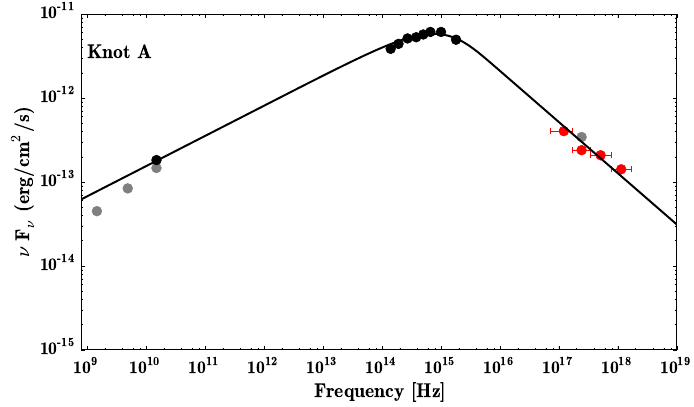
Figure 12. Representative multi-wavelength SED for the outer knot A in the kpc-scale jet of M87 including X-ray emission (red) based on 1.5 Msec of Chandra data. The emission is thought to be synchrotron in origin, indicating the presence of electrons up to multi-TeV energies within the jet. Inverse Compton up-scattering off various soft photon fields (starlight, dust, EBL, CMB) would result in a steady VHE contribution. From Ref.